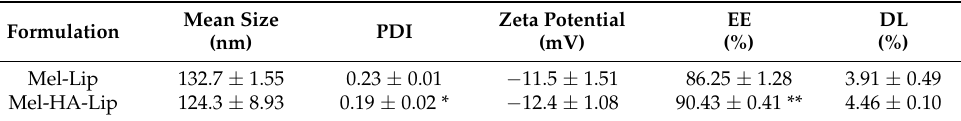
Table 2. Characterization of Mel-Lip and Mel-HA-Lip. ( n = 3).